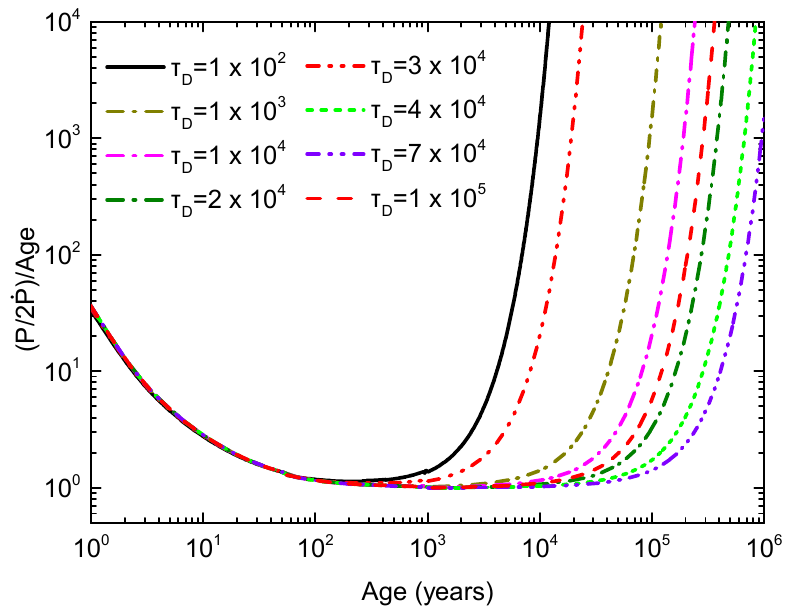
Figure 8. Spin-down age ( P /2 ˙ P ) over the true age of the star as a function of the real age for a neutron star whose magnetic field emerges, after the burial due to a hyper-accretion phase, and then it is followed by a